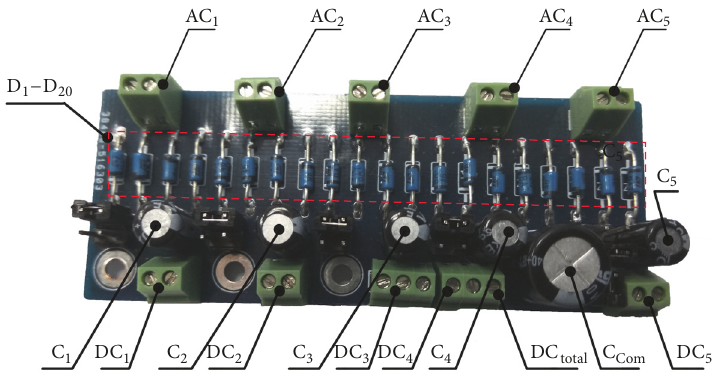
Figure 12: Electronic interface for the energy